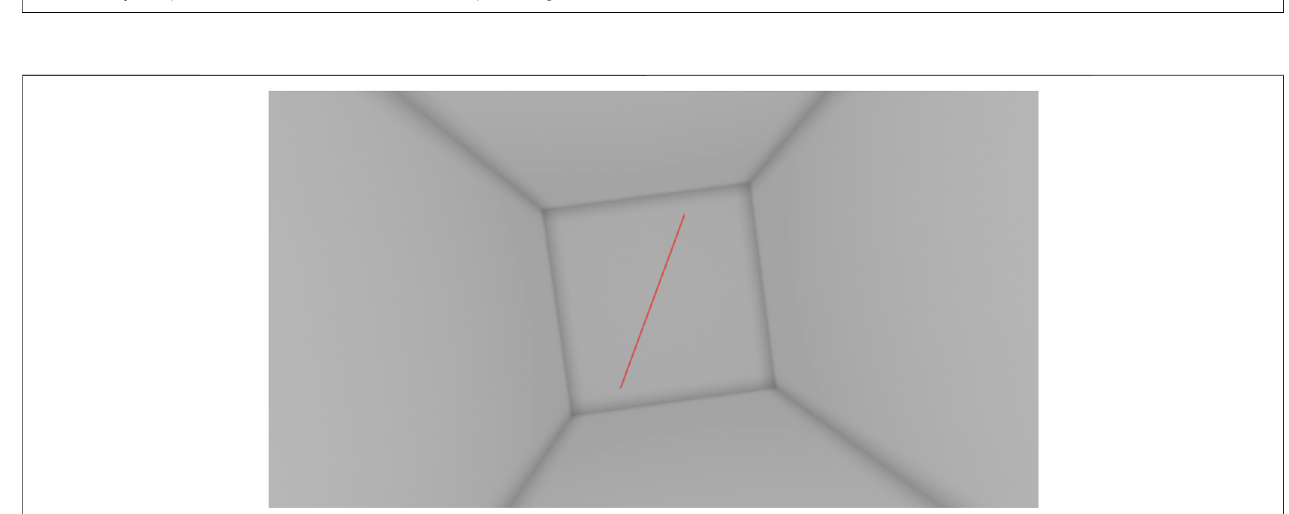
FIGURE 2 | First-person view of the virtual Rod and Frame Test (RVR software, Virtualis ® ) at the beginning of a trial.